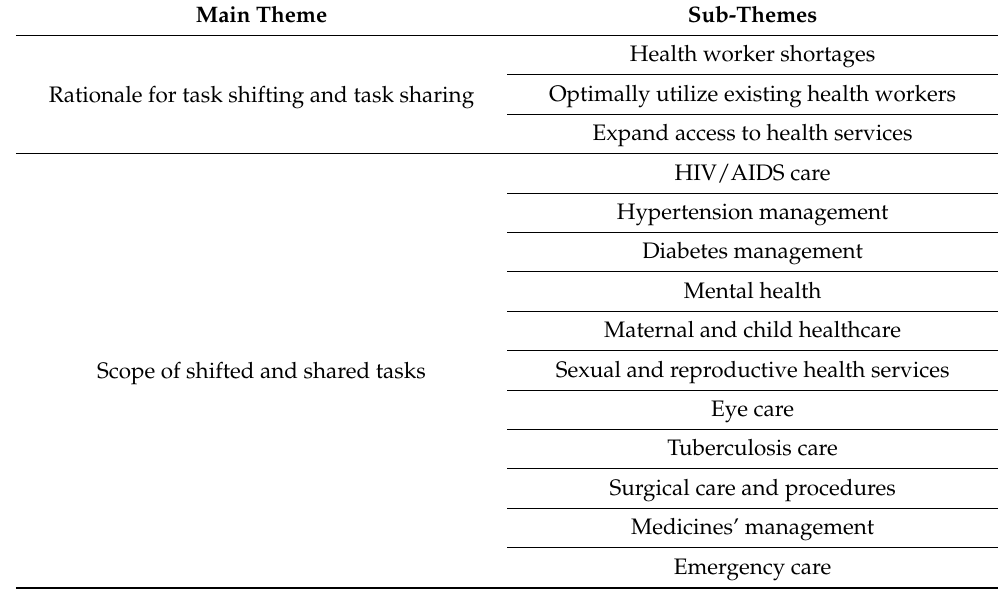
Table 5. Main theme and sub-themes.